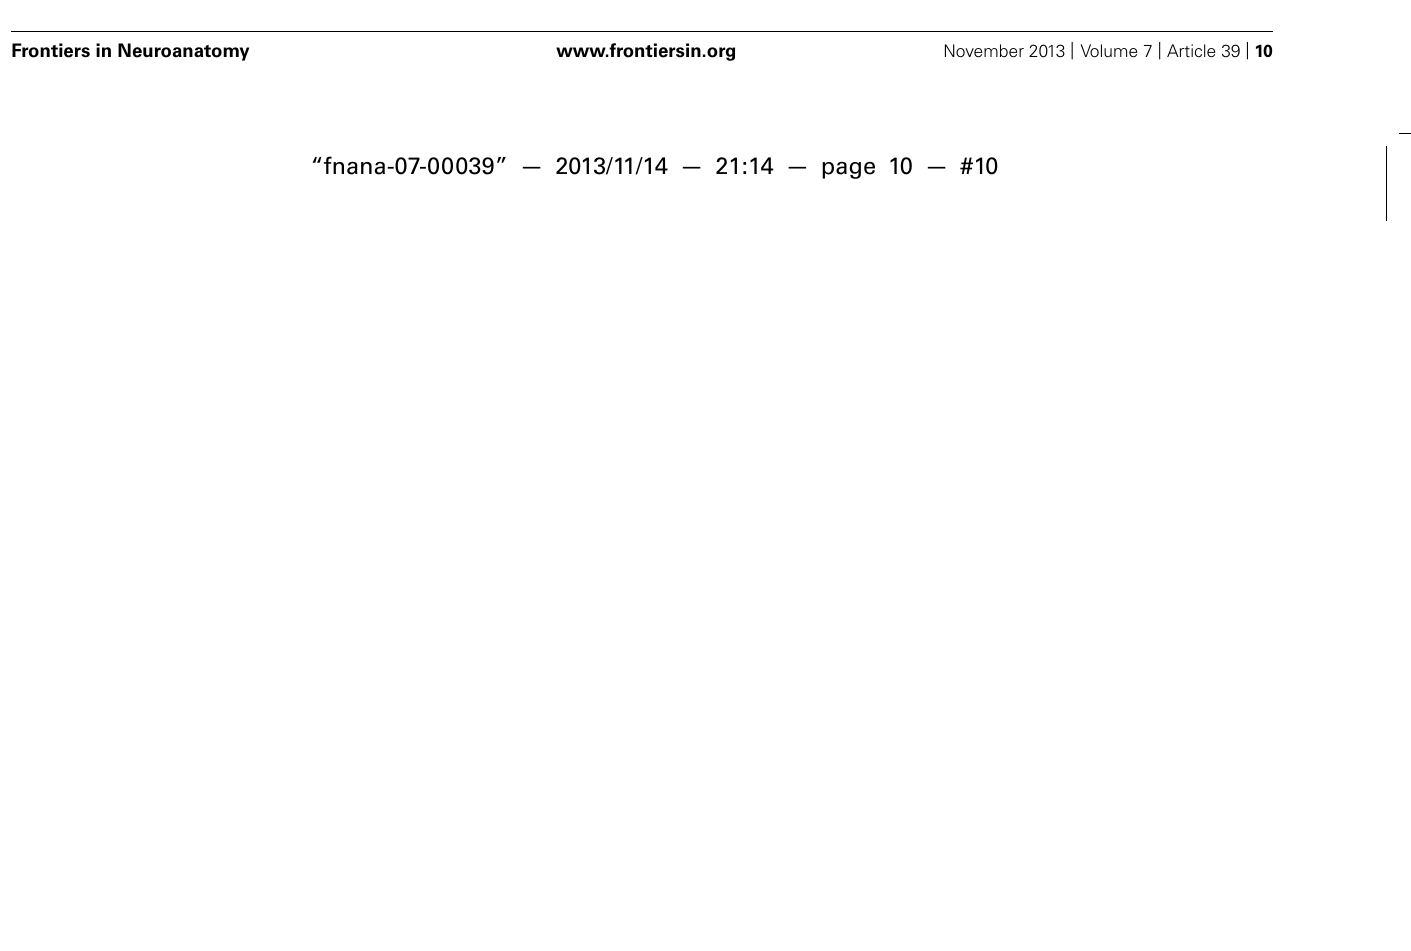
FIGURE 7 |Topography of the naked mole-rat cerebellum with electrophysiological mapping of cutaneous and periodontal responses from the anterior lobe, lobulus simplexA and B, the vermis and ansiform lobule. (A) Schematic of the microelectrode-derived map of cutaneous inputs to the cerebellum labeled according to corresponding receptive fields. Dark